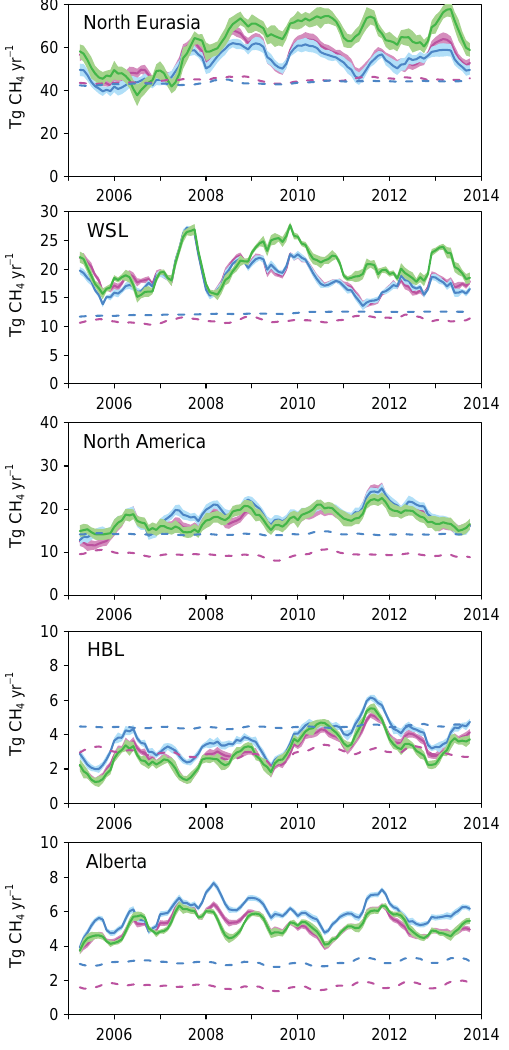
Figure 12. Mean seasonal cycles (2005–2013) of the integrated CH 4 flux for different regions (units Tgyr − 1 ) . The grey shading in- dicates the standard deviation of the monthly fluxes. The solid lines show the posterior fluxes and the dashed lines show the prior fluxes. Magenta is for scenario S1 (including wetland fluxes from LPX- Bern), blue is for S2 (including wetland fluxes from LPJ-DGVM), and black (dashed) is for prior anthropogenic fluxes.